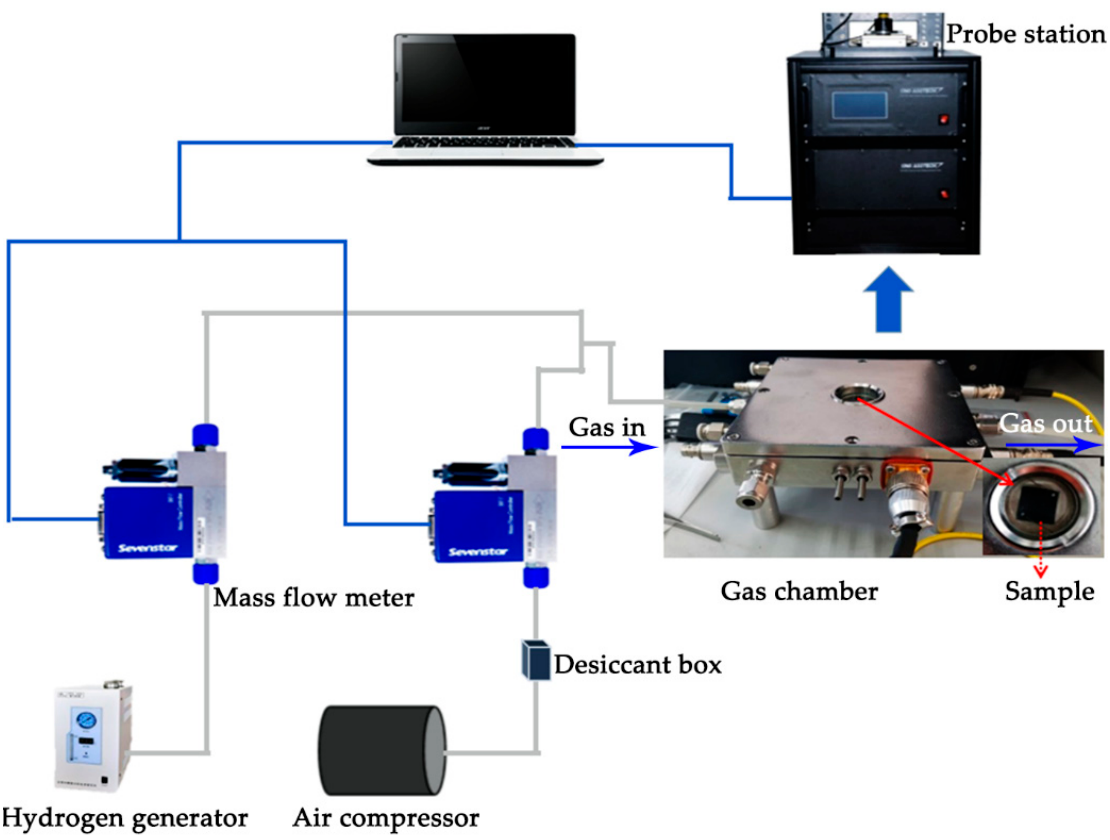
Figure 1. Schematic diagram of the hydrogen sensor measurement system.